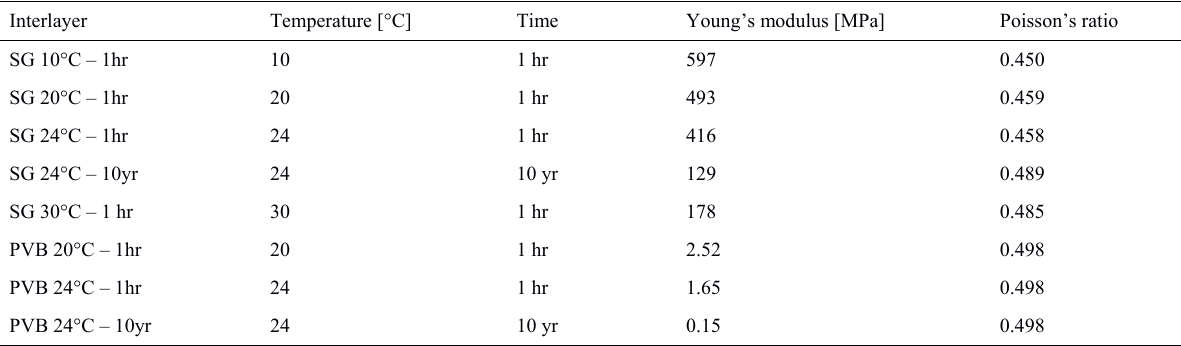
Table 3: Mechanical properties of the SG and PVB interlayer.